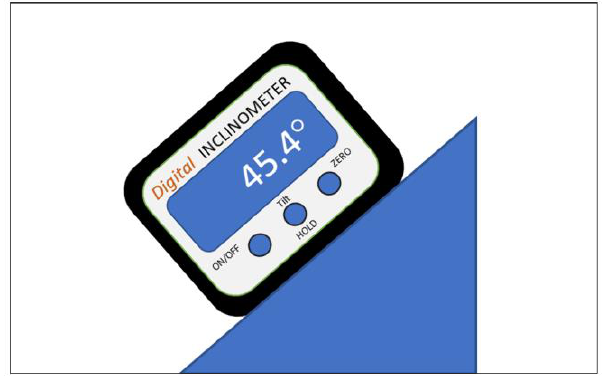
Figure 2. A clinometer is used to measure the angular position of the aerial parts of the sample tree (e.g., tree stem, tree branch, and tree trunk).